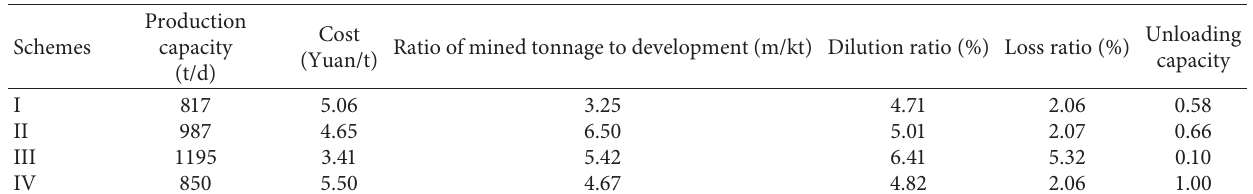
Table 3: Technical and economic indicators.